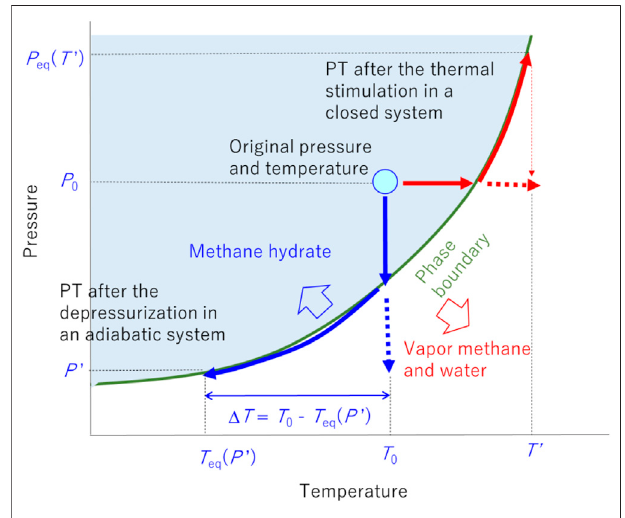
FIGURE 1 | Phase equilibrium line and PT changes during the application of the “ depressurization method (blue arrows) ” and the “ thermal stimulation method (red arrows) .